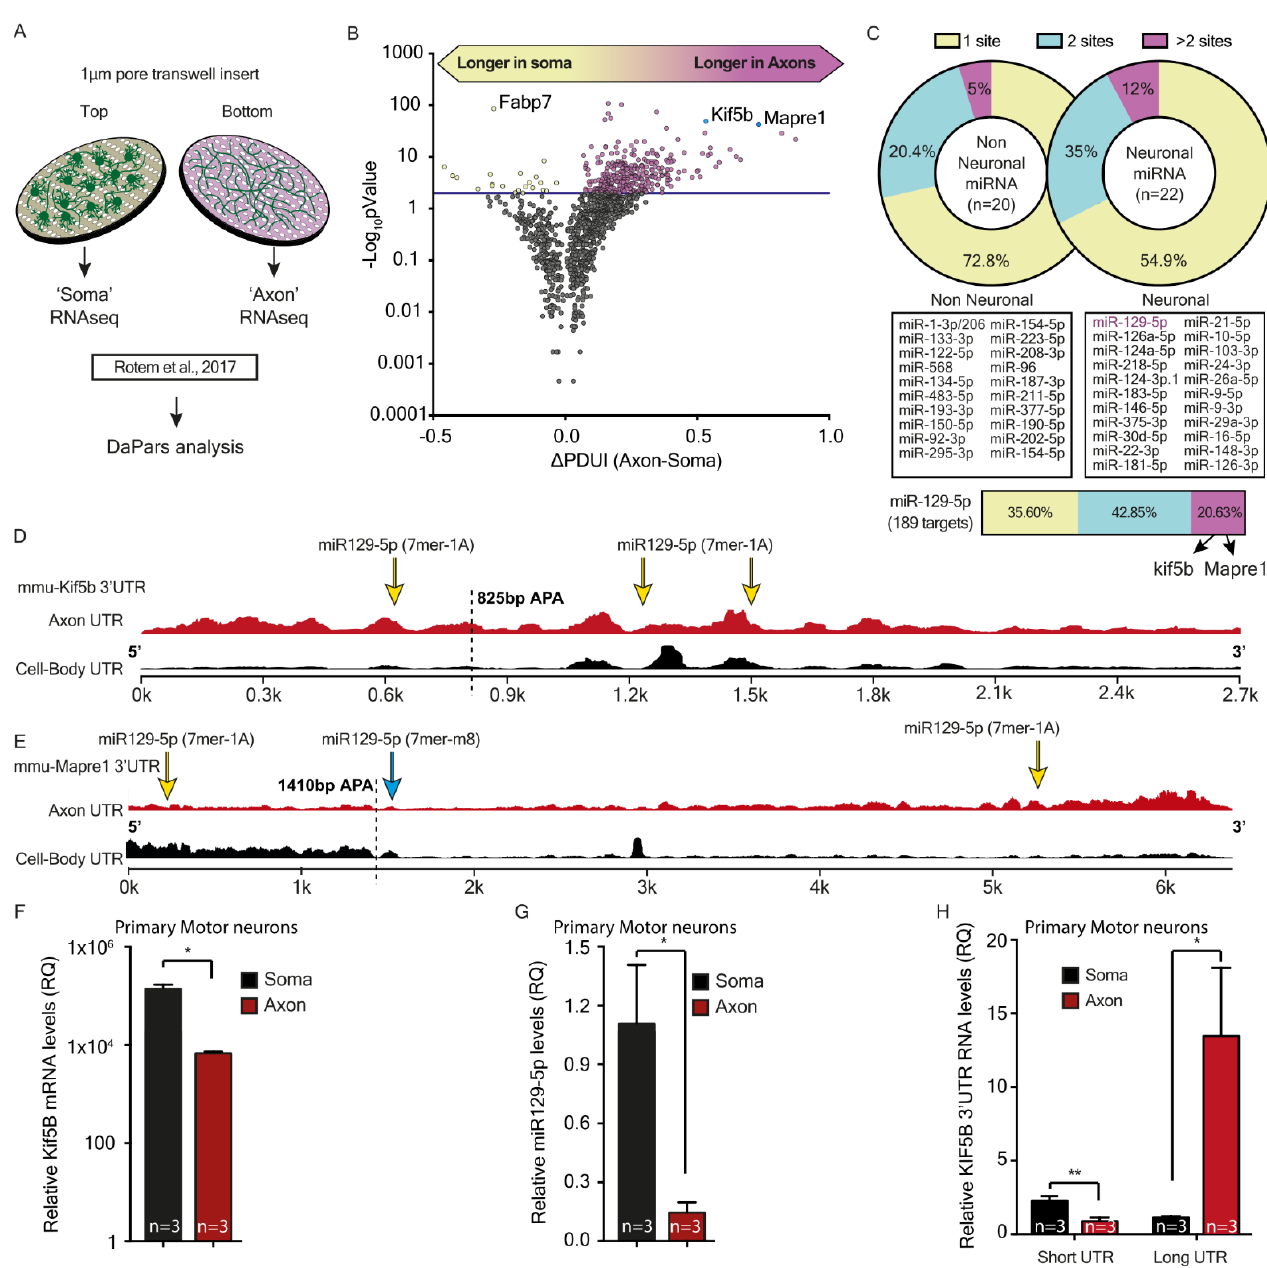
Figure 4. Kif5b mRNA transcript variant length and expression at axon versus cell-body motor neurons. ( A ) Illustration of the transwell insert method used for isolation of axonal RNA from primary motor neuron (MNs). ( B ) A volcano plot demonstrating results of the Dynamitic analysis of Alternative Poly-Adenylation from RNA-seq (DaPars) analysis for the Δ PDUI, representing the differences in the short vs. long 3′ UTR ratios in axons vs. cell bodies. Significantly elongated 477 mRNA transcripts are colored in red. Kif5b and Mapre1 (blue) were chosen for further validations. ( C ) Upper panel: analysis of the percent of long 3′ UTR transcripts containing 1, 2, or >2 target sequences for neuronal versus non-neuronal miRNAs. The middle panel shows the list of neuronal and non-neuronal miRNAs tested. The lower panel details the specific percent of miR-129-5p targets within the long 3′ UTR transcripts that contain 1, 2, or >2 target sequences. Two transcripts with more than two target sequences for miR-129-5p are highlighted: Kif5b and Mapre1. ( D ) The diagram compares 3′ UTR coverage of the Kif5b transcript in axons (red) versus cell-bodies (black). The alternative polyadenylation (APA) site is marked with a black dashed line. The yellow arrows indicate positions of miR-129-5p target sequences. ( E ) The diagram compares 3′ UTR coverage of Mapre1 transcript in axons (red) versus cell-bodies (black). The APA site is marked with a black dashed line. The yellow